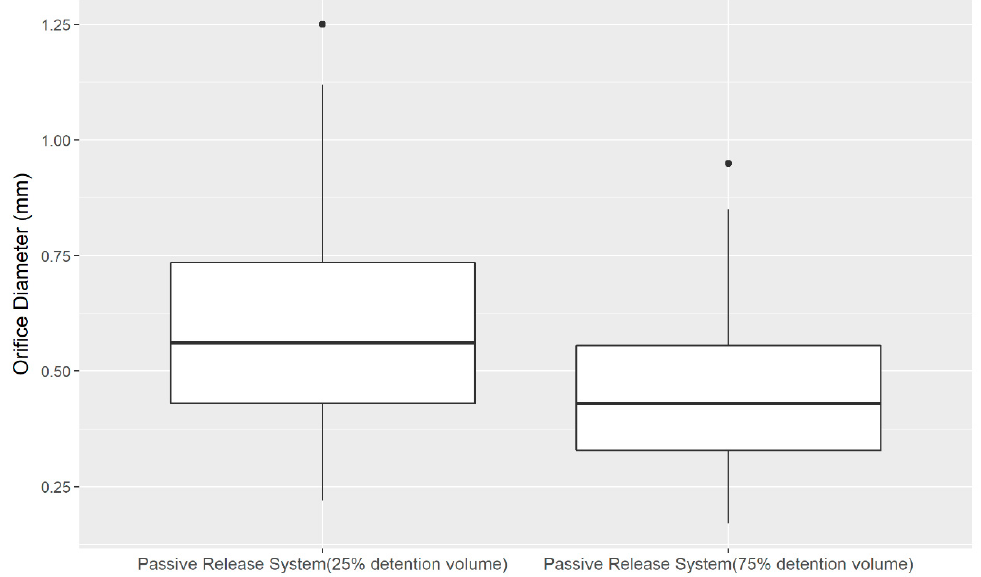
Figure 7. The theoretical prediction of equivalent orifice size for passive release system with 25% and 75% detention volume respectively.